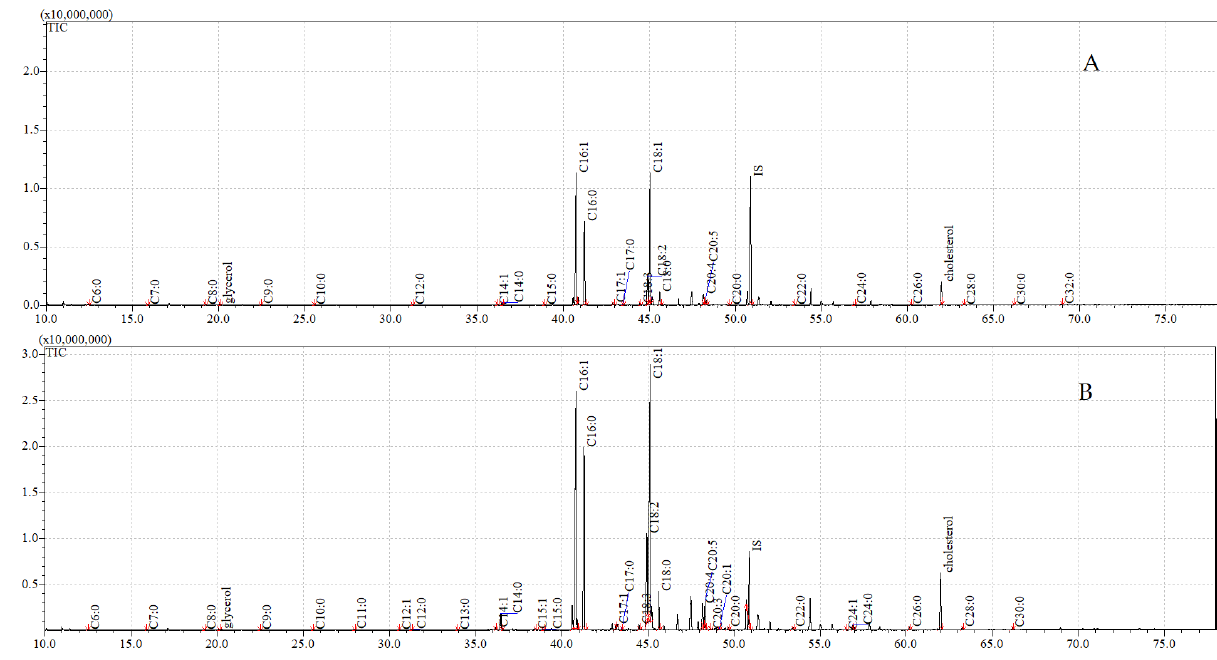
Figure 7. The total ion current (TIC) chromatogram of fatty acids (TMS esters) of the dichloromethane extract after sonification (extract III) from control (A) and after C. coronatus exposition (B) S. argyrostoma imago . Internal standard (IS, 19-methylarachidic acid); the following fatty acids and molecular ions: hexanoic acid (C6:0, m / z = 188), heptanoic acid (C7:0, m / z = 202), octanoic acid (C8:0, m / z = 216), nonanoic acid (C9:0, m / z = 230), decanoic acid (C10:0, m / z = 244), undecanoic acid (C11:0, m / z = 258), dodecenoic acid (C12:1, m / z = 270), dodecanoic acid (C12:0, m / z = 272), tridecanoic acid (C13:0,